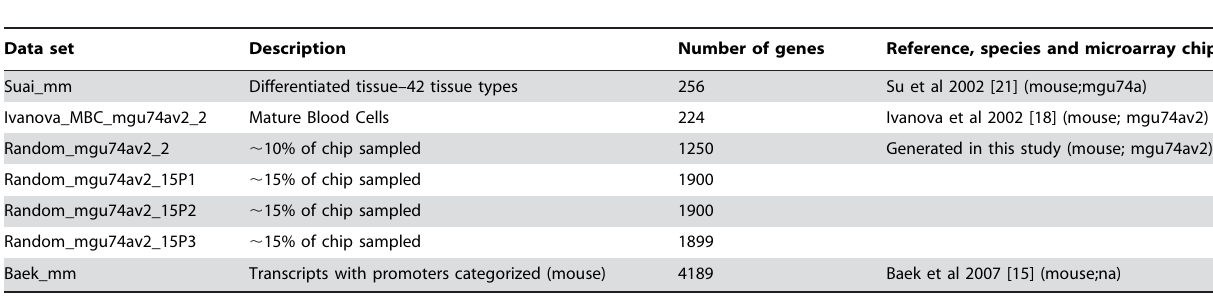
Table 2. The seven negative control sets included in the